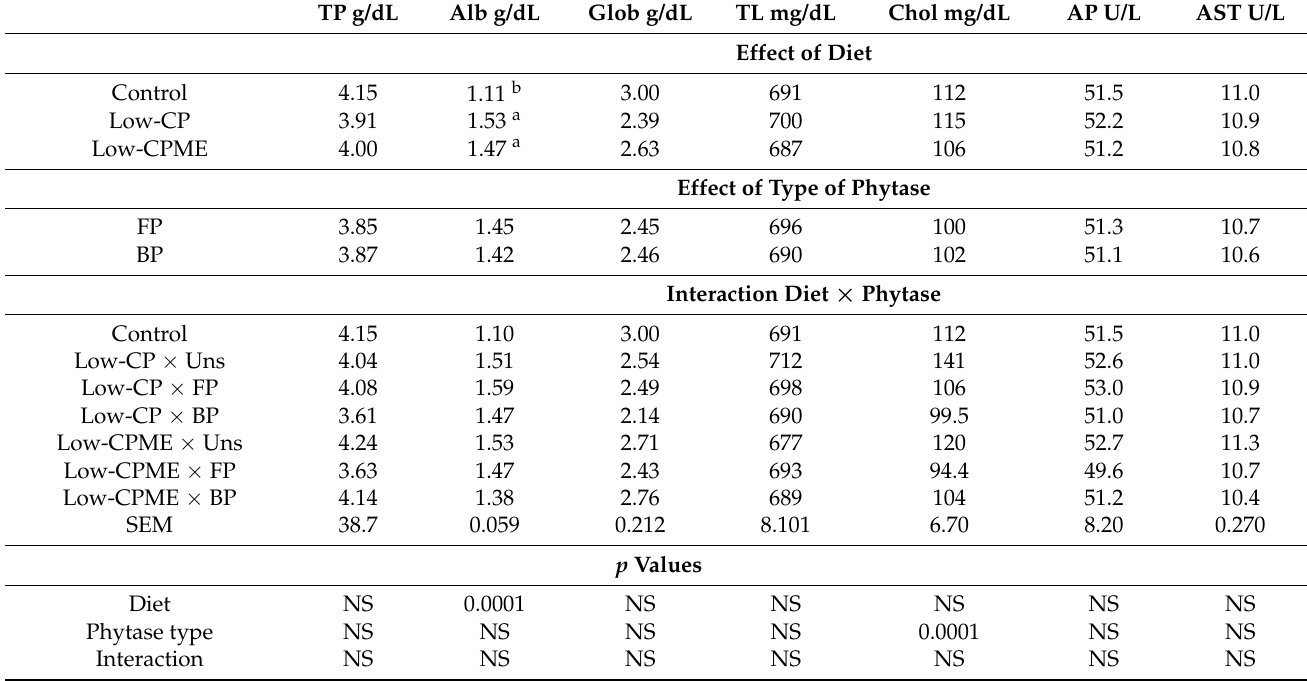
Table 6. Effect of diet, type of phytase, and their interaction on blood traits of